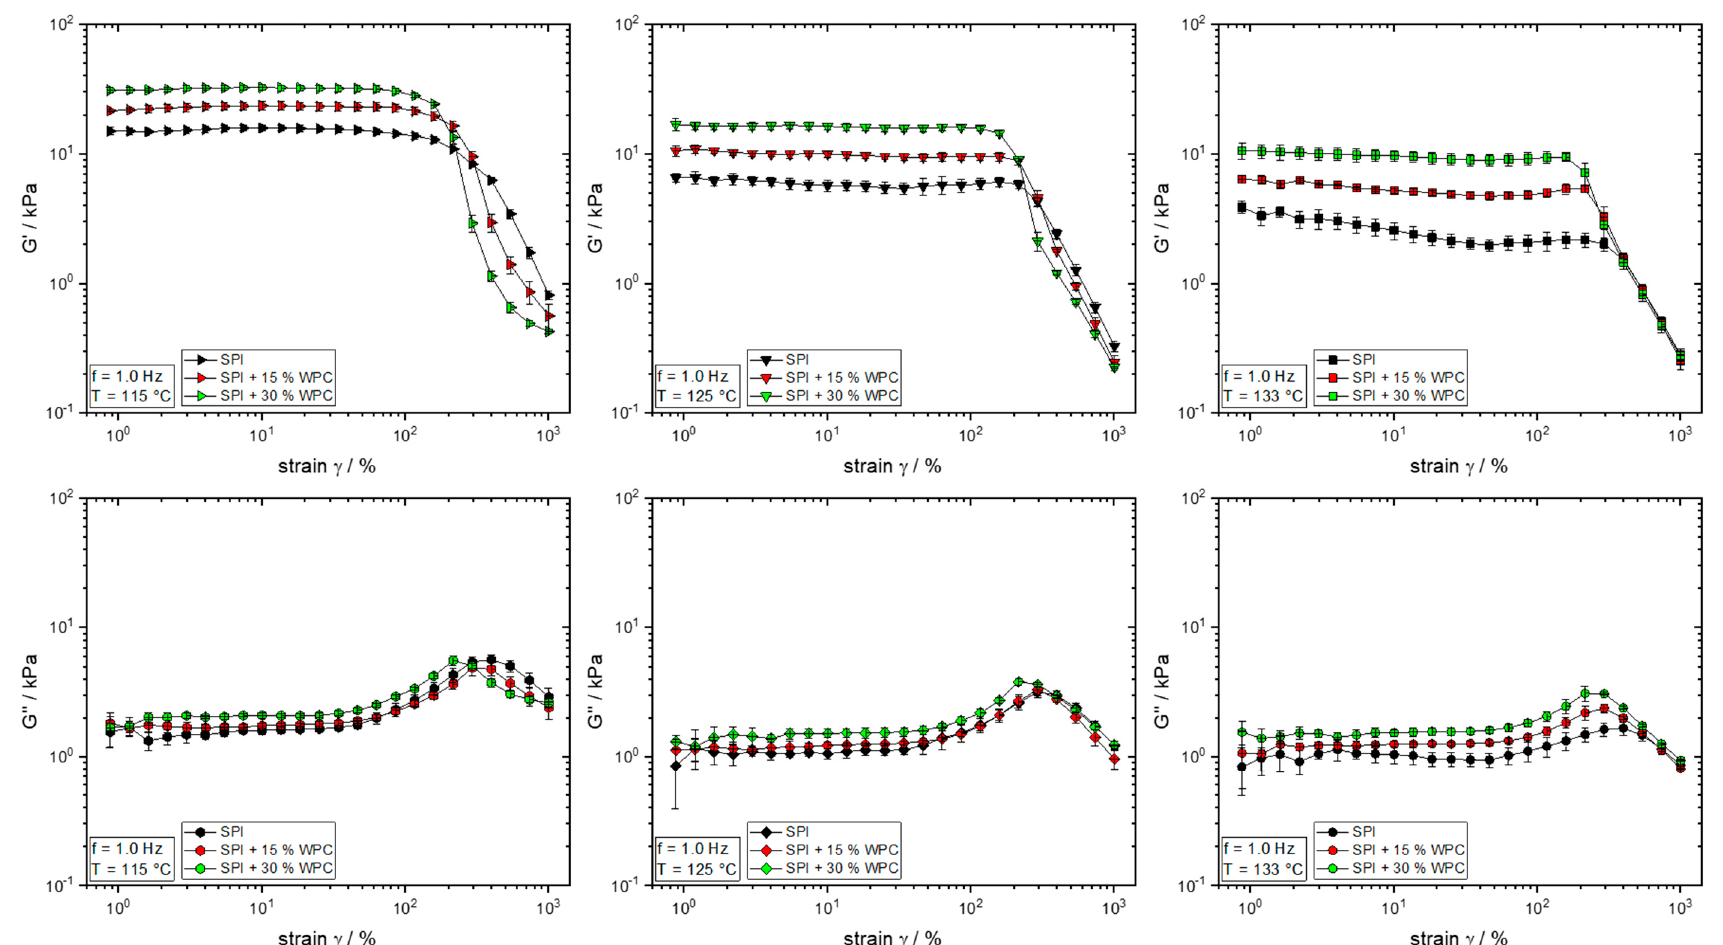
Figure 8. Storage modulus G’ and loss modulus G’’ as a function of strain γ for different protein blends (0–30% WPC) and temperatures (115–133 °C).